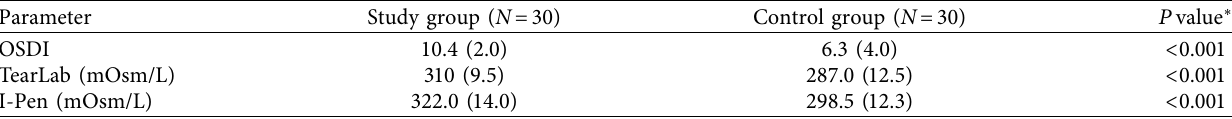
Table 1: Median (IQR) OSDI and osmolarity scores for subjects in the study and control groups.